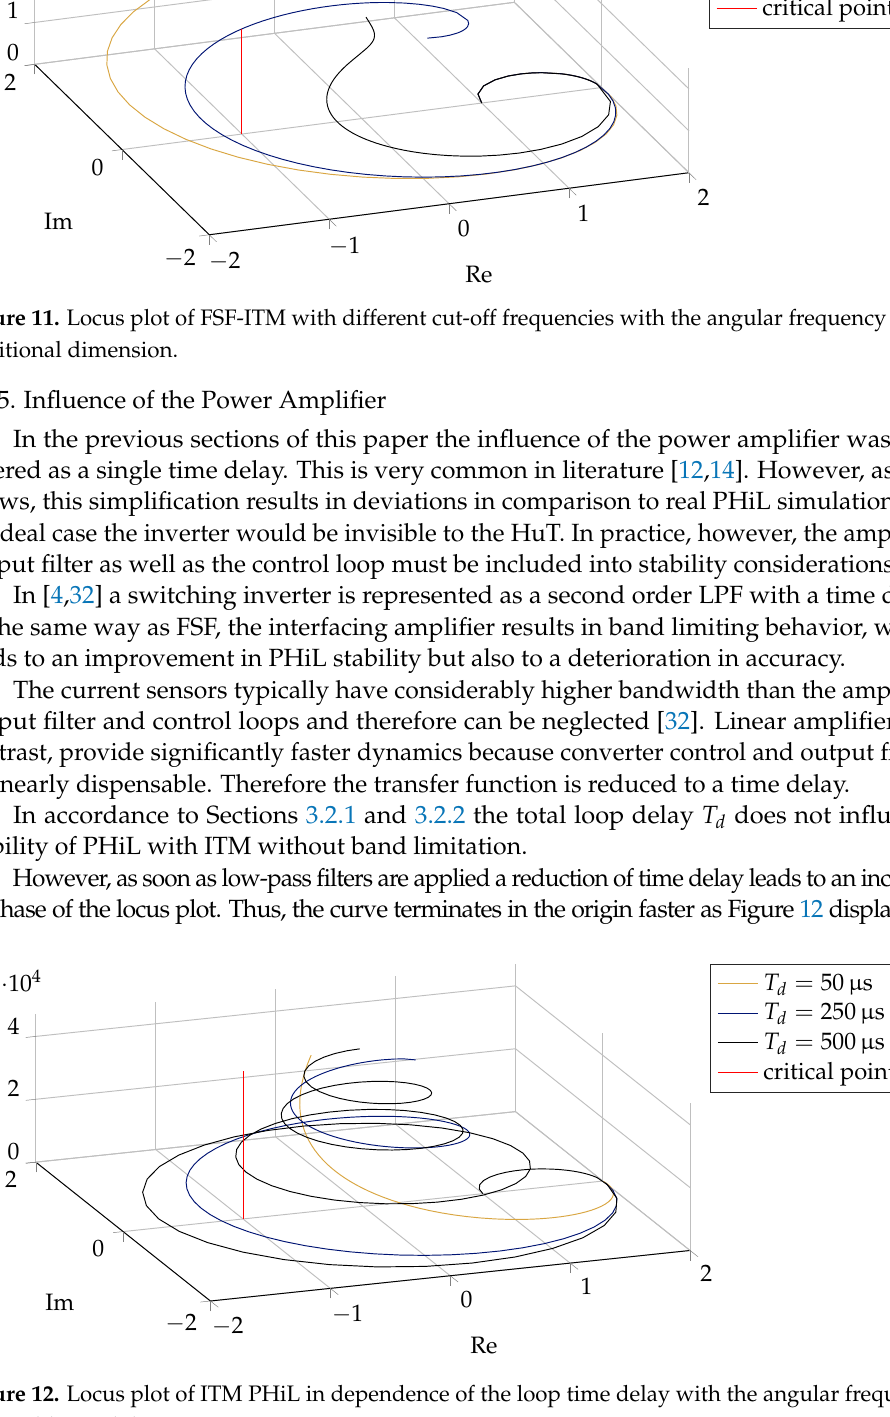
T d = 590 µ s, f g = 2.12kHz Figure 13. Locus plot of voltage type ITM PHiL with different loop time delays and low pass cut of frequencies. Consequently a reduction in the loop time delay T d , through a decrease in simulation sample time or faster power amplifier dynamics, will lead to stability at higher filter cut-off frequencies which in turn improves modeling accuracy. 4. Simulative and Experimental Stability Validation In this section the findings of the theoretical stability analysis are applied to a PHiL model, which is fully implemented in an offline emt -simulation in MATLAB Simulink™, to